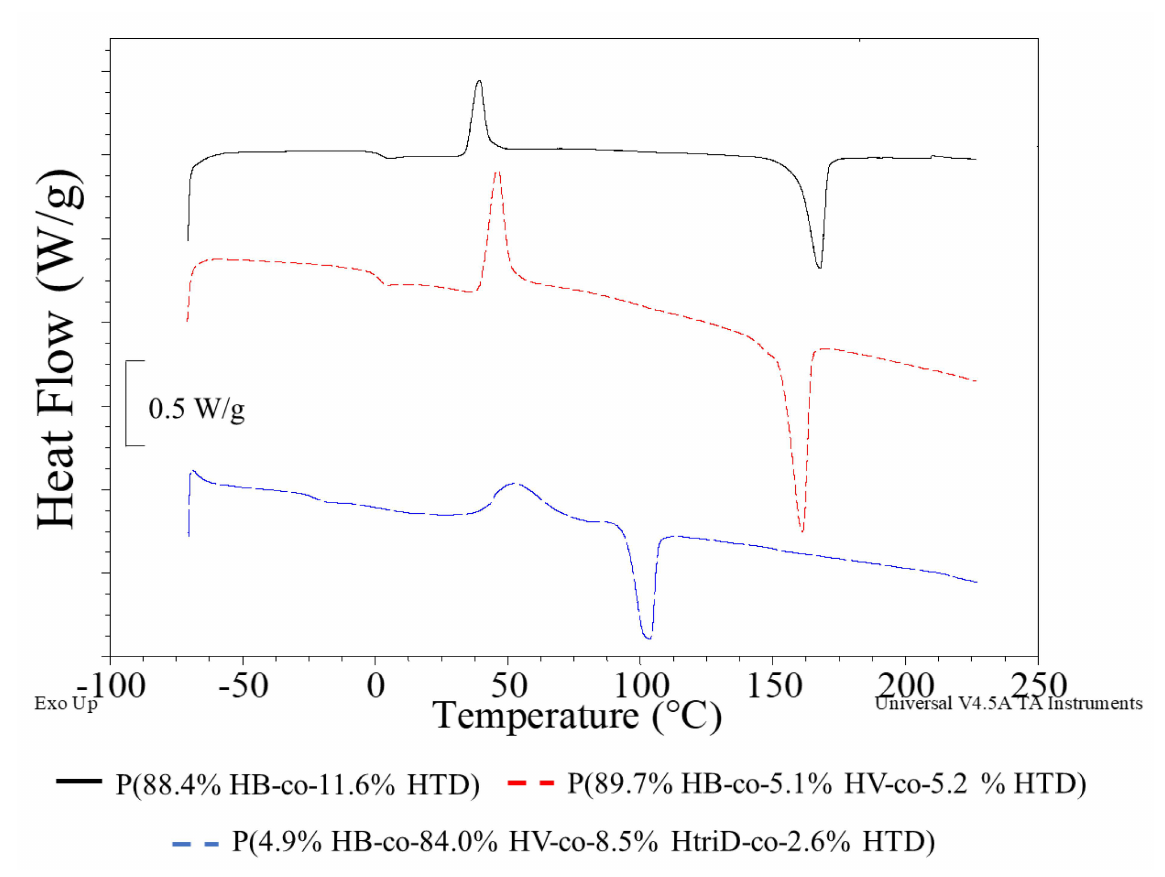
Figure 5. DSC curves of selected samples: ( black line ) P(88.4% HB-co-11.6% HTD) extracted from the culture supplemented with 10% SMCFAs synthetic -rich stream under nitrogen-limited condition ( red line ) P(89.7% HB-co-5.1% HV-co-5.2% HTD) extracted from the culture supplemented with 1 g/L of caproic acid under non-limited condition, ( blue line ) P(4.9% HB-co-84.0% HV-co-8.5% HtriD-co 2.6% HTD) extracted from the culture supplemented with 2 g/L of valeric acid under nitrogen-limited